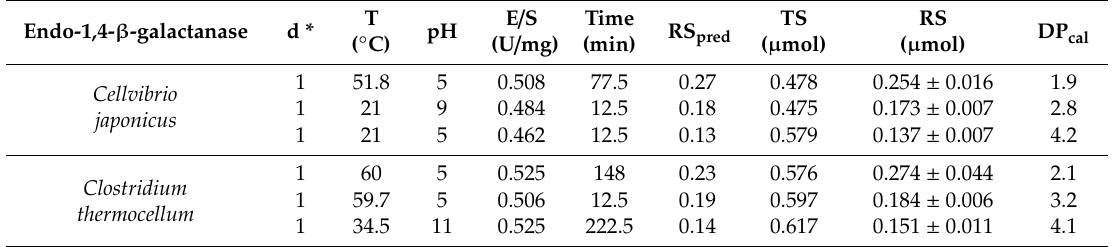
Table 5. Validation of optimal conditions for the production of PGOs with DPs of 2, 3, and 4. Endo-1,4- β